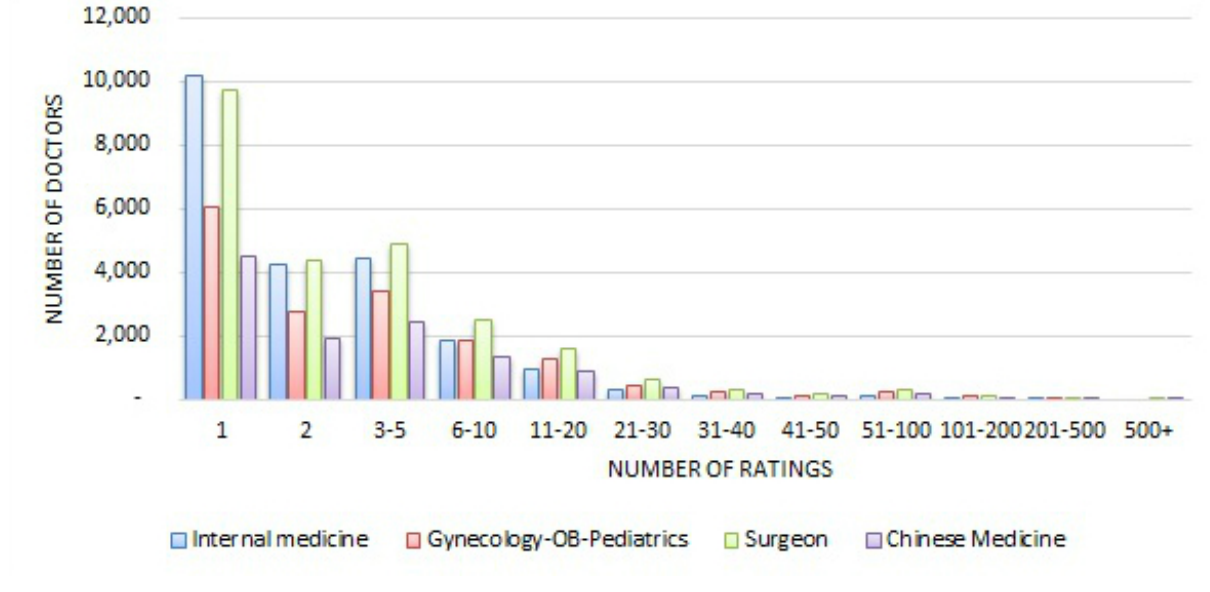
Figure 1. Distribution of the number of ratings across four major specialty areas (absolute number).